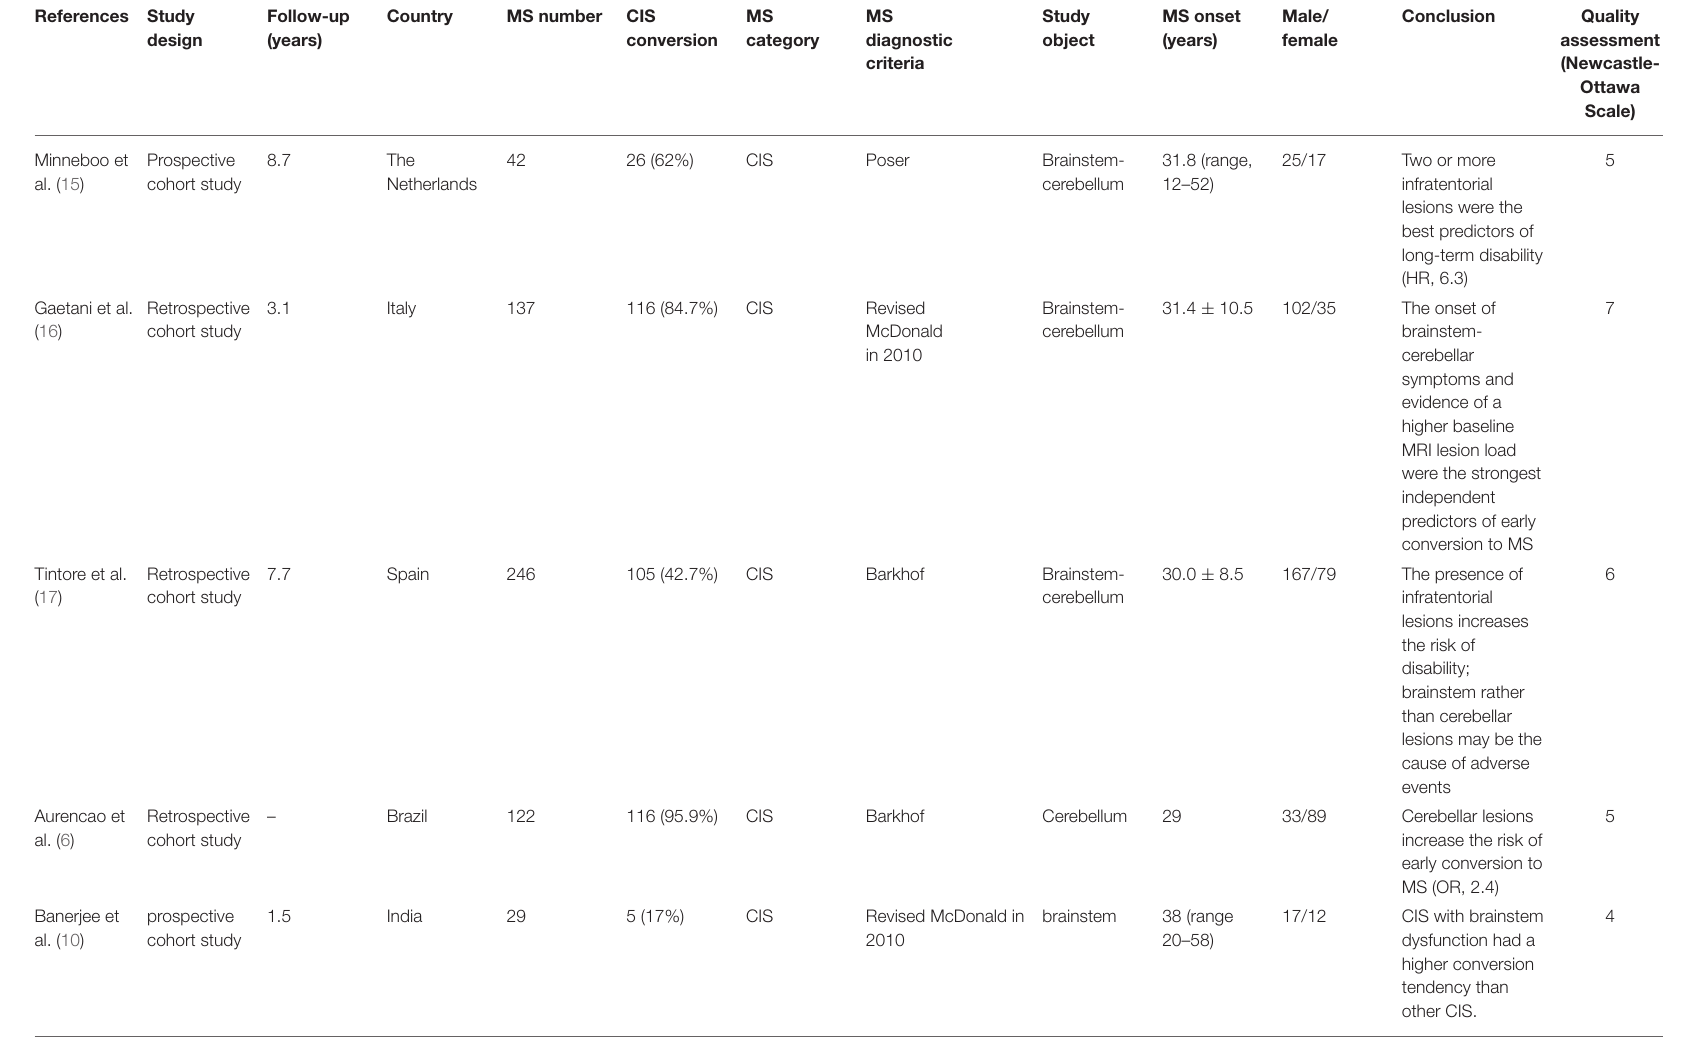
TABLE 1 | Basic characteristics of the included